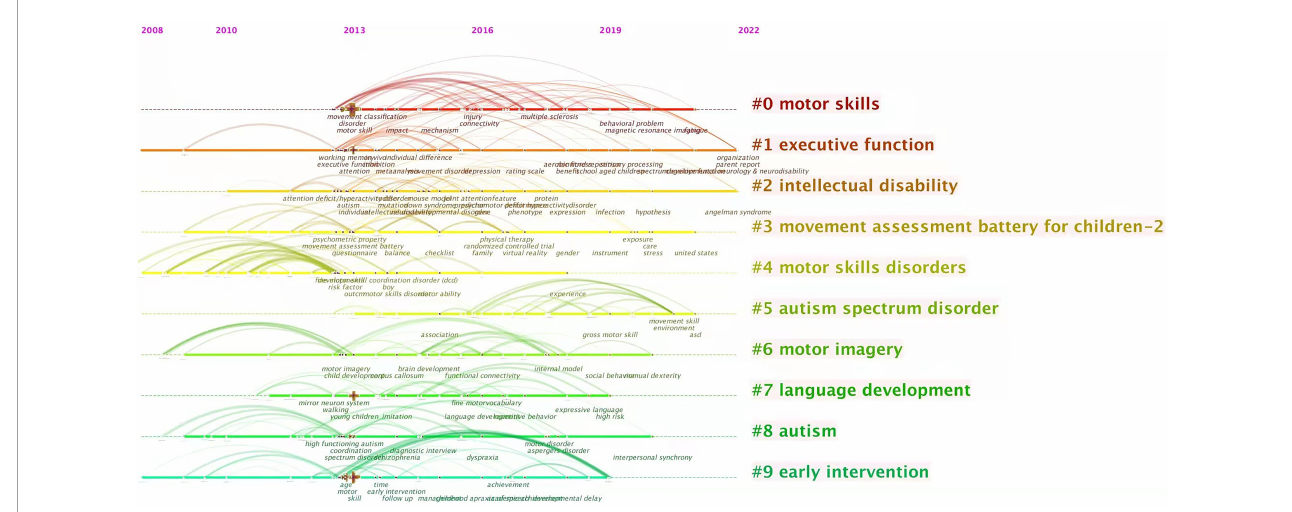
FIGURE5 Co-current zone of keywords analysis. The nodes on the ten horizontal lines in the diagram are the keywords and their corresponding occurrence times, the rightmost labels are the keyword clusters, and the keyword clusters from #0 to #9 are arranged in descending order of the number of